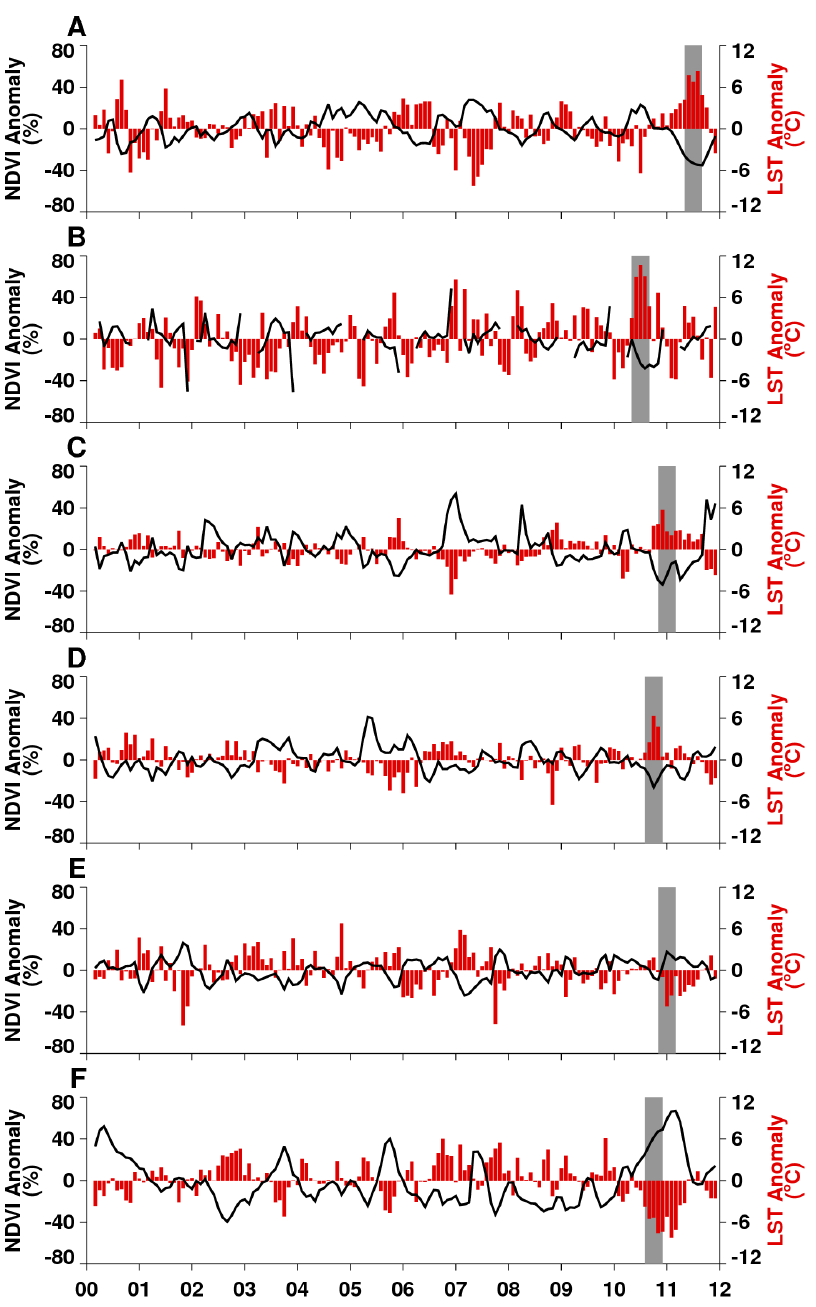
Figure 2. Monthly time series of 2000–2012 MODIS normalized difference vegetation index (NDVI; black line) and land surface temperature (LST; vertical red bars) anomalies for agricultural regions shown in Figure 1 and Figure S1 in File S1. Grey bars indicate selected periods of focused impact studies for each region.